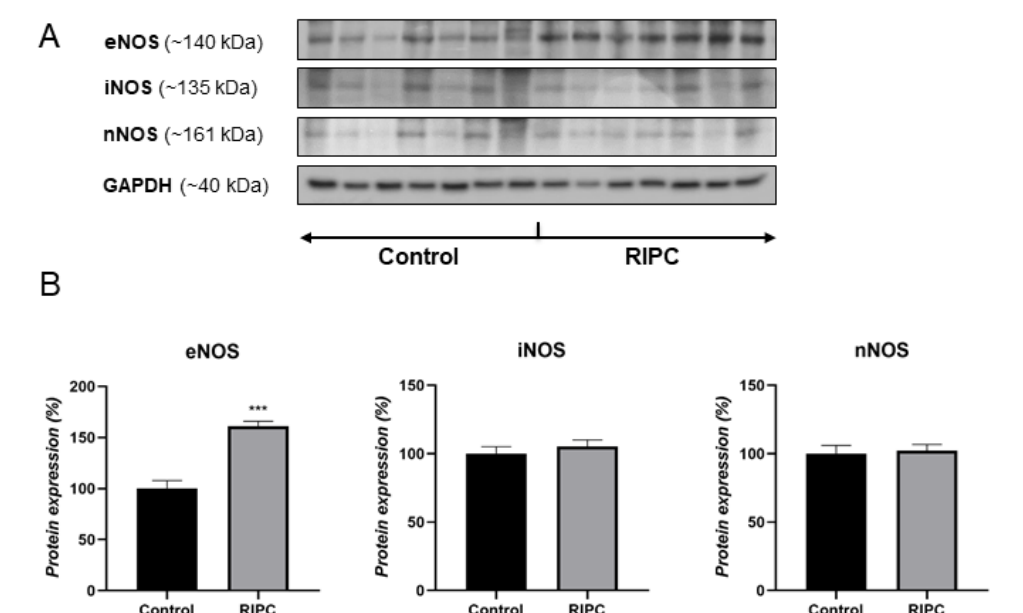
Figure 1. Western blot data showing protein expression of eNOS, iNOS, and nNOS in ITA of non-RIPC (control) patients (left) and patients with applied RIPC protocol (right) during urgent CABG ( A ). Representative bands from the same blot corresponding to seven patients in each group are shown. Data obtained after quantification of specific bands expressed as % of the control group taken as 100% ( B ). Bars represent the mean ± S.E.M. *** p < 0.001.